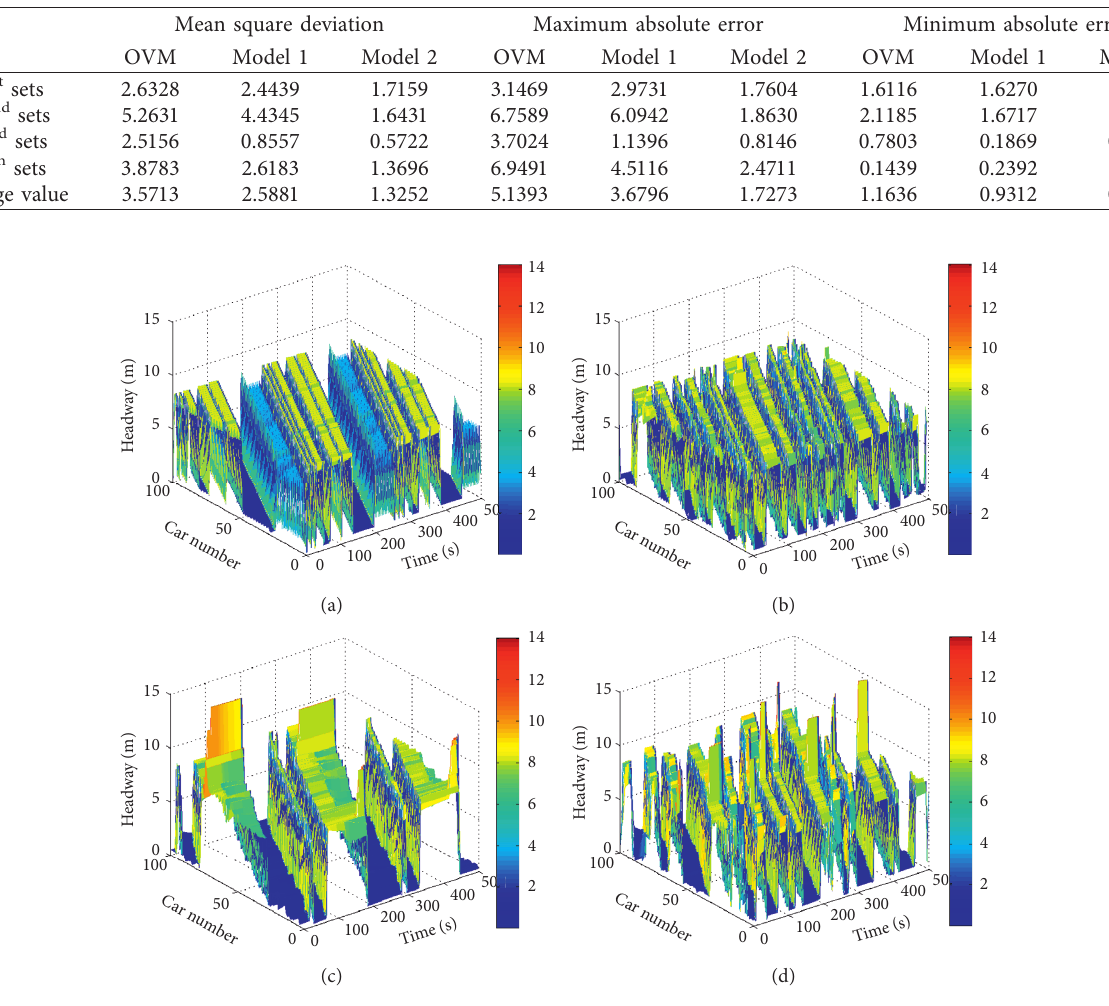
Figure 7: Space-time evolution of the headway after t � 10000s for small disturbance with different p : (a) p � 0, (b) p � 0 . 2, (c) p � 0 . 4, and (d) p � 0 .